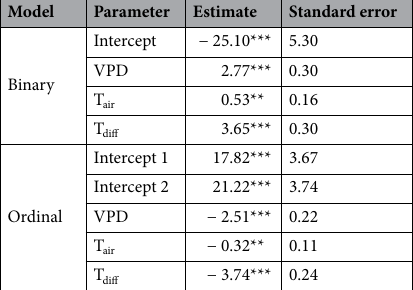
(2018–2019) used as validation, the classified performance of the CART model displayed a sensitivity of 0.75, specificity of 0.97, geometric mean of 0.85, and accuracy of 92.18% (Table 4). The CART model revealed a com- parable and better performance than that of the logistic model when using different testing datasets, with a sen- sitivity of 0.87–1.00, specificity of 0.89–0.93, geometric mean of 0.90–0.94, and 90.82–92.11% accuracy (Table 4). Classification ability of ordinal response models. In the ordinal response models, the training and testing datasets were same as the binary response models. The performances of the classified ability of the ordinal